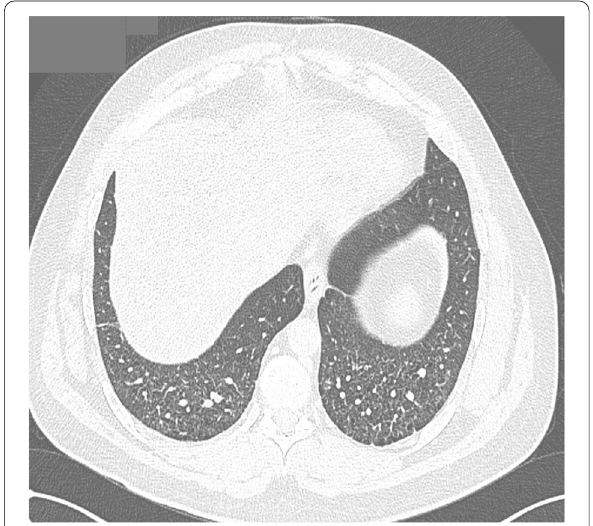
Fig. 3 HRCT of the chest, axial image, showing less numerous cysts in lower